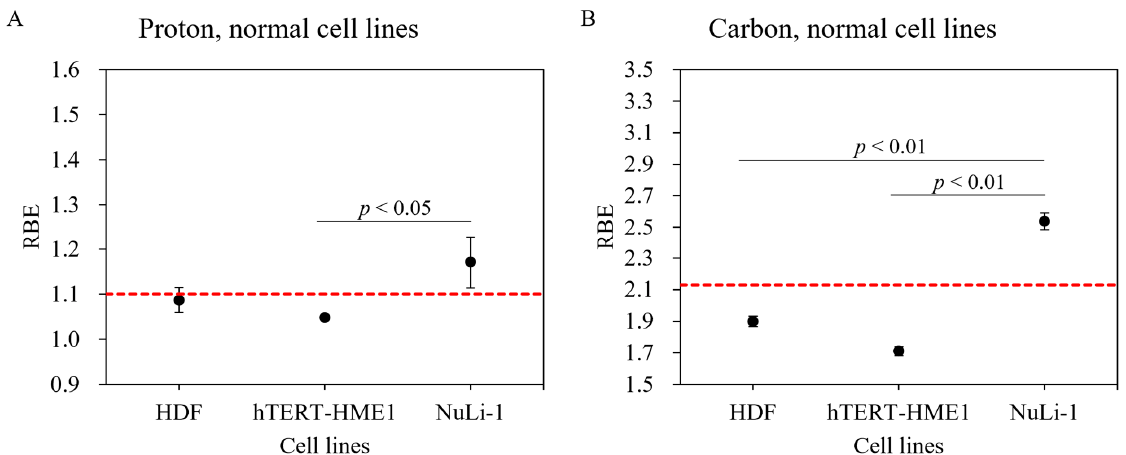
Figure 4. RBE values of various normal cell lines using proton and carbon-ion irradiation. Normal cell lines irradiated with ( A ) proton beam and ( B ) carbon ions. Bars represent confidence intervals of one standard deviation. The red dashed line indicates RBE values of 1.1 for proton beam and 2.13 for carbon-ion irradiations.